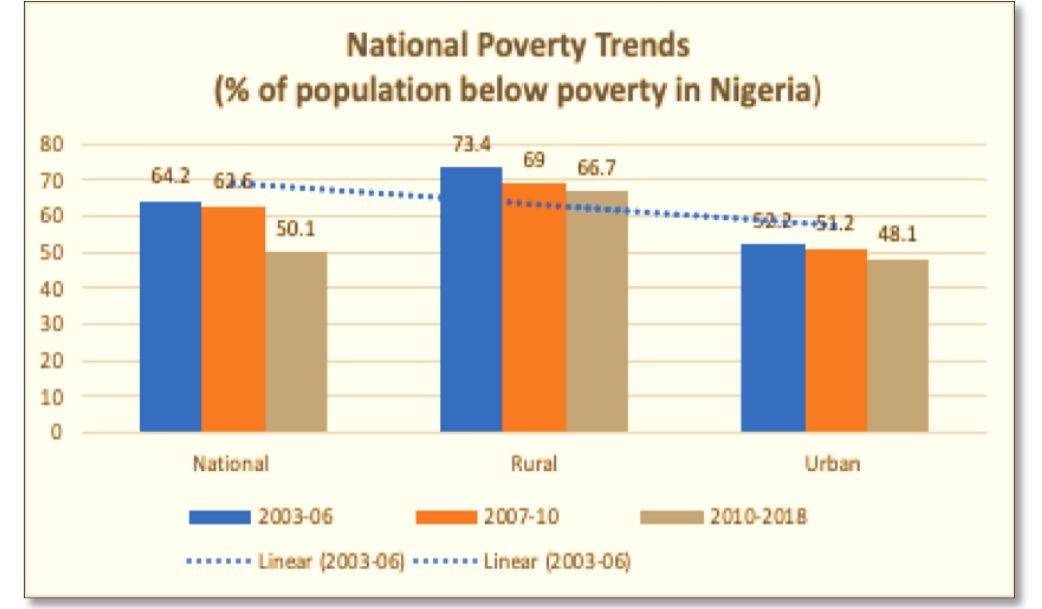
Figure 8. Nigerian National Poverty Trends showing % of population living below line (between 2003 and 2018). Source: Author.